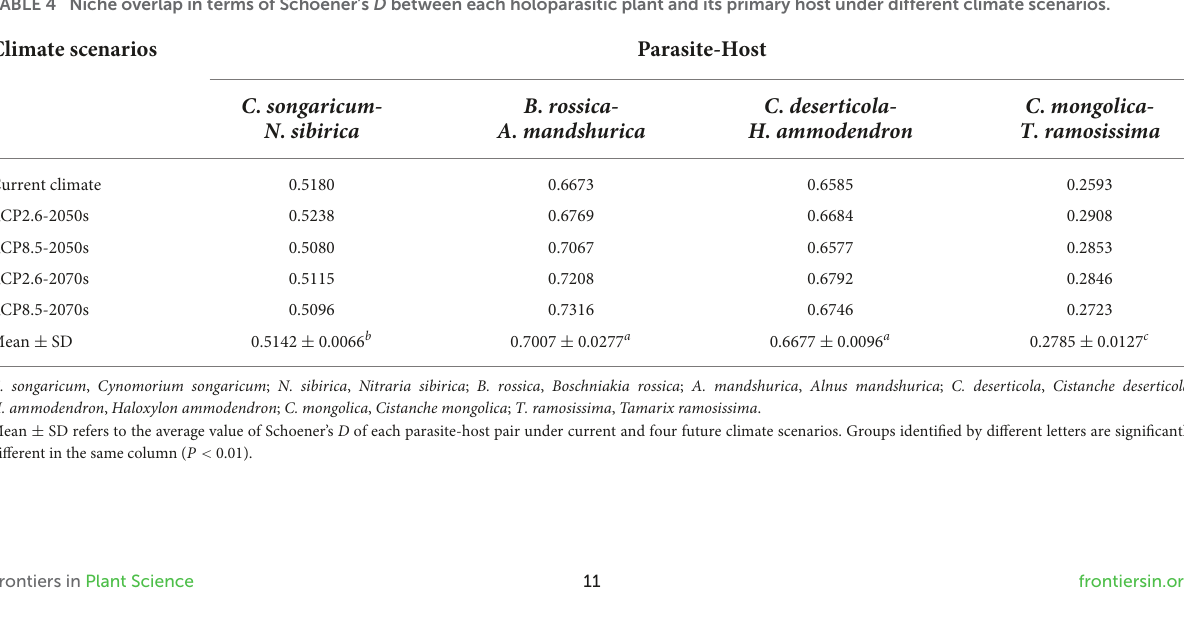
TABLE 4 Niche overlap in terms of Schoener’s D between each holoparasitic plant and its primary host under different climate